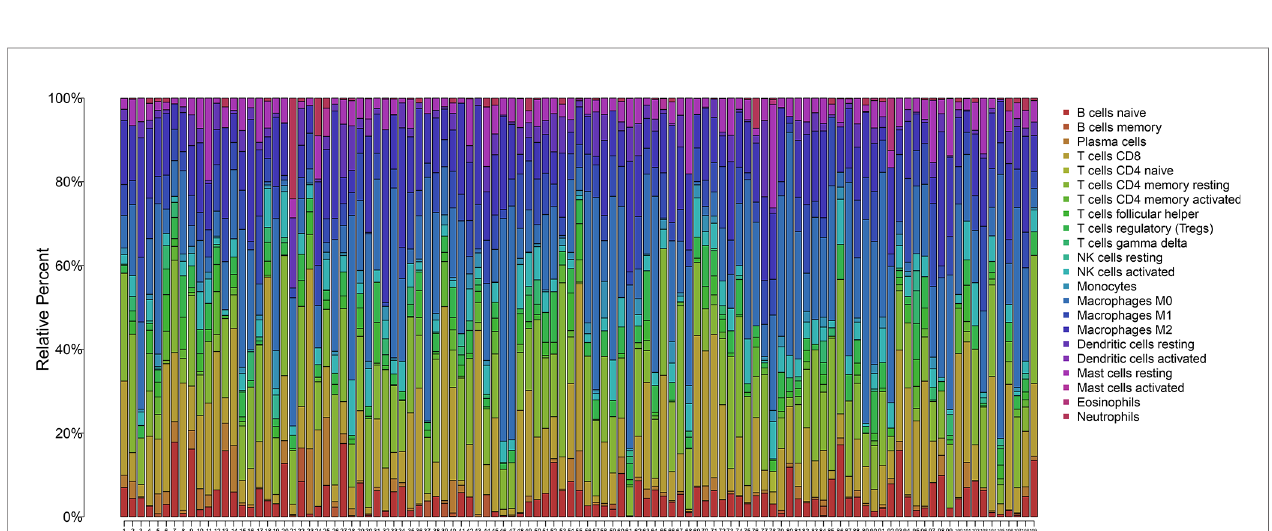
FIGURE 7 | Percentage of the 22 types of immune cells in 109 HCC samples with high TGF- b 1 expression using the corrplot package. CIBERSORT tool was used to analyze the data from the 374 HCC patients extracted from TCGA. Data with p > 0.05 were fi ltered out, with 109 samples left as shown in the x -axis and Supplementary Table 2 . The y -axis shows the percentage of immune cells in each patient.